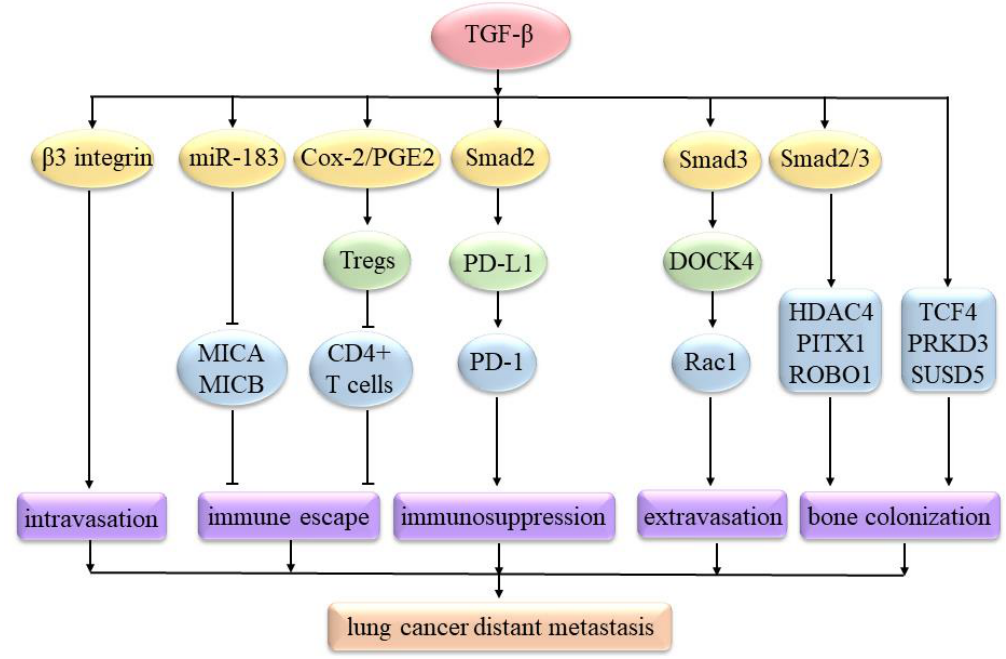
Figure 2. TGF- β signaling regulates lung cancer’s distant metastasis. TGF- β can increase β 3 integrin Figure 2. TGF-β signaling regulates lung cancer’s distant metastasis. TGF-β can increase β3 integrin expression to enhance cancer cell intravasation. TGF- β can increase Tregs via Cox-2 / PGE2 to suppress expression to enhance cancer cell intravasation. TGF-β can increase Tregs via Cox-2/PGE2 to suppress the proliferation of CD4+ T cells, thus driving lung CTCs to escape from immune attacks. immune detection. TGF- β 1 / Smad2 can up-regulate PD-L1. PD-L1 can bind to PD-1 to suppress anti-tumor immunity. TGF- β / Smad3 can induce dedicator of cytokinesis 4 (DOCK4)